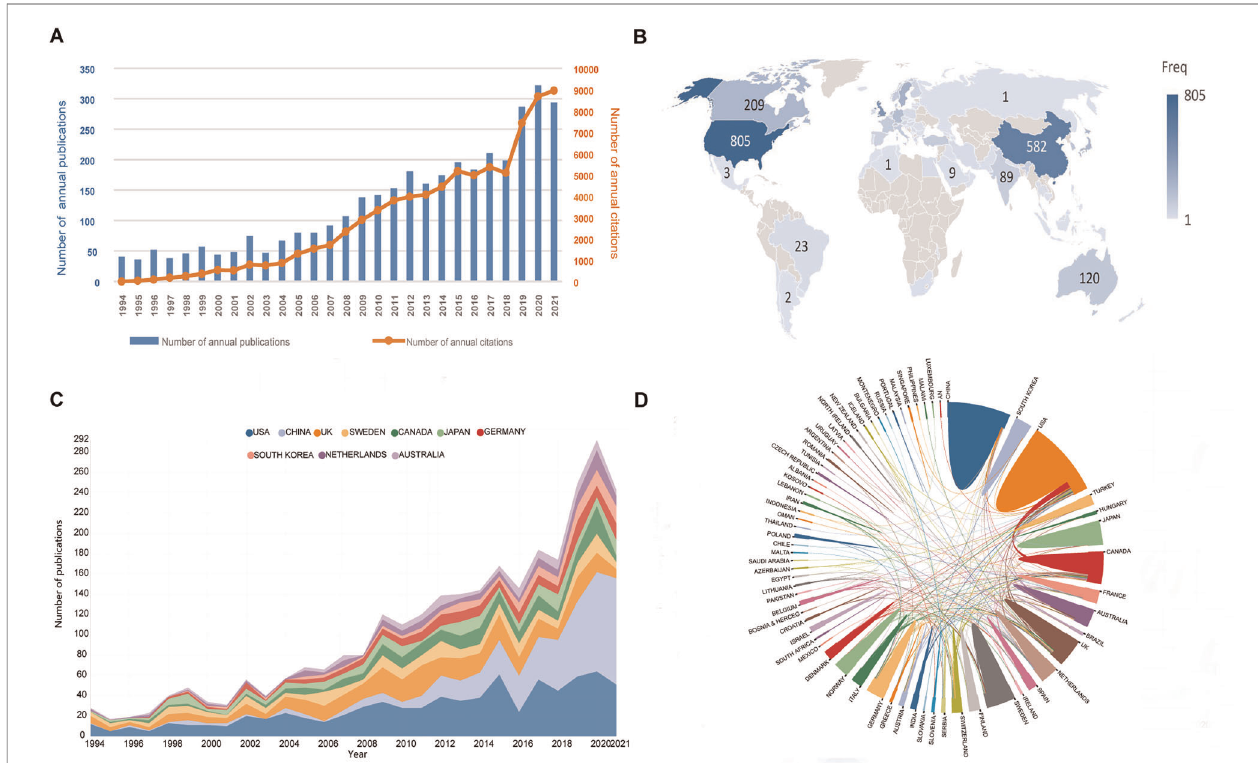
FIGURE 2 | ( A ) The number of annual publications and citations on FNF research from 1994 to 2021. ( B ) A world map displaying the contribution of countries in FNF research. Countries were coded with different colors depending on the number of publications. ( C ) The annual number of publications in the top 10 most productive countries from 1994 to 2021. The width of the line in different colors re fl ects the changing trend of annual publications in different countries at different time points. ( D ) The cooperation map of countries/regions involved in FNF research. The thickness of each line re fl ects the tightness of cooperation, and a thicker line indicates a stronger cooperation.